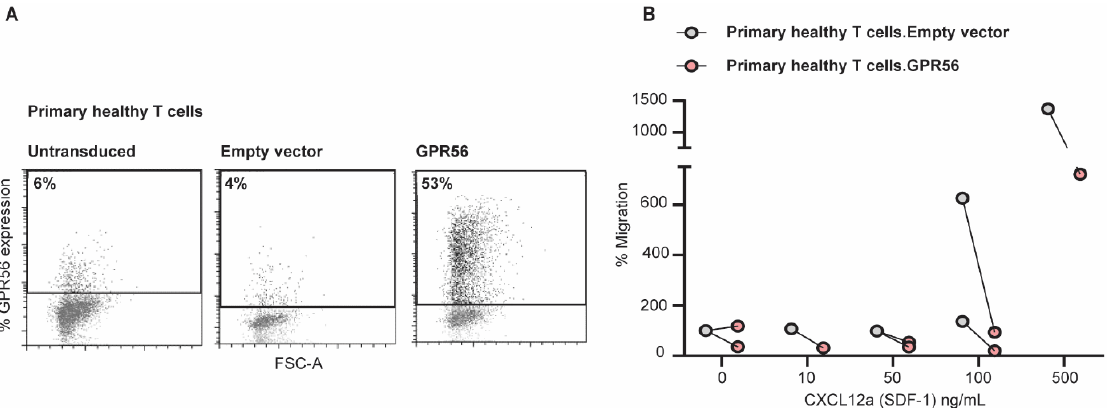
Figure 5. Ectopic GPR56 expression inhibits migration of primary healthy T cells. ( A ) Primary healthy T cells ectopically expressing GPR56 were generated by transducing T cells with lentivirus containing pRRL-SFFV-GPR56-iGFP or pRRL-SFFV-iGFP. After 3 days the GPR56 expression was evaluated by flow cytometry. ( B ) Migration in response to chemoattractant CXCL12a was performed with primary healthy T cells lentivirally transduced with pRRL-SFFV-GPR56-iGFP or an empty vector. Primary healthy T cells were loaded in a volume of 100 μL on transwell filters with a pore size of 5 μm. SDF-1 (CXCL12) was added as chemoattractant to the lower compartment at a concentration of 0–500 ng/mL in a total volume of 200 μL of migration buffer. After 2.5 h incubation percentage of migration was calculated considering the migration of the primary healthy T cells